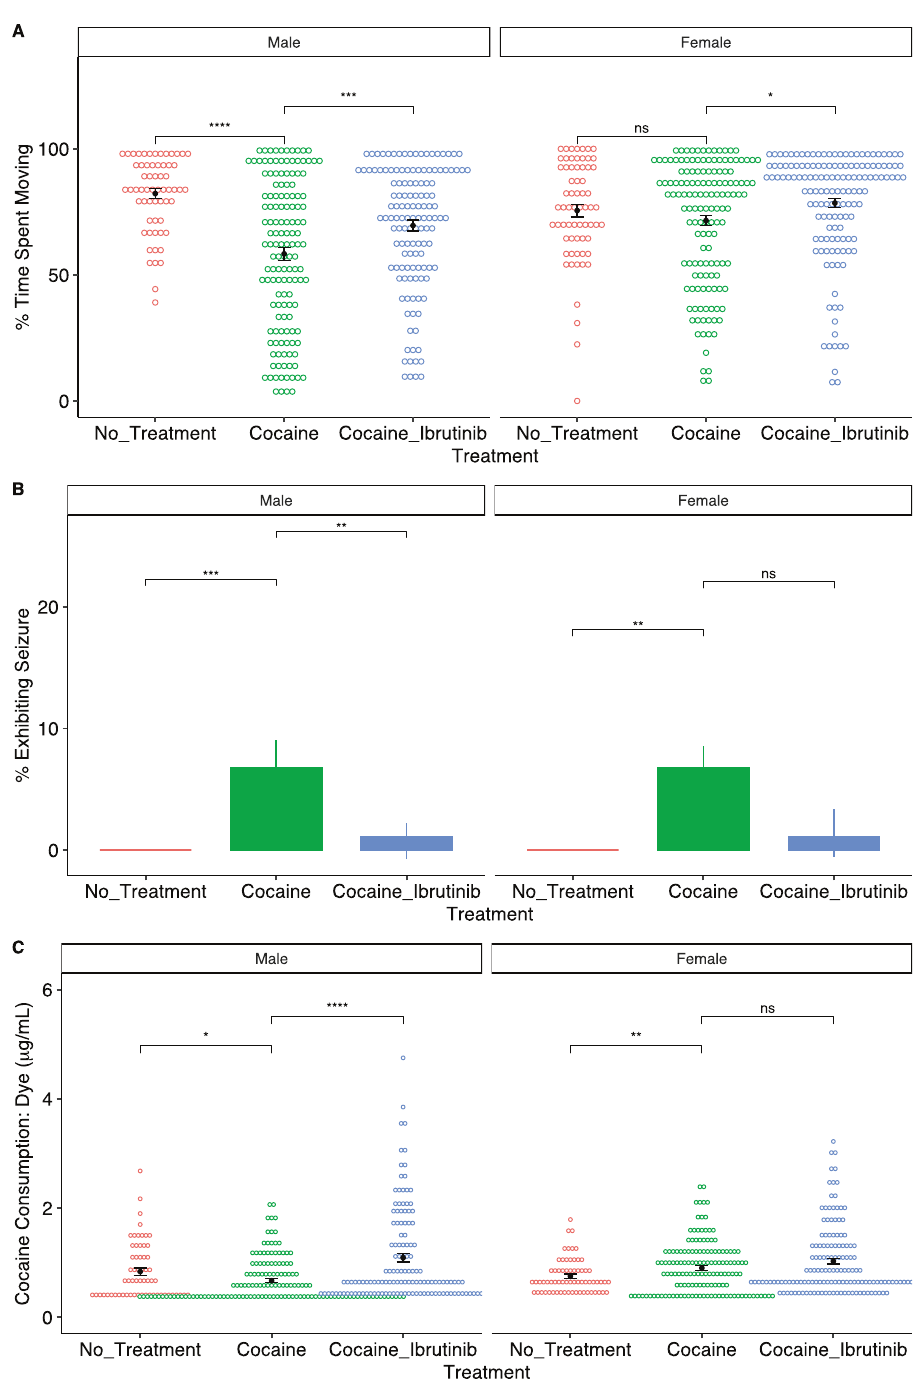
Fig. 5 Ibrutinib in fl uences cocaine-induced startle response, cocaine-induced seizures and cocaine consumption in Drosophila melanogaster . Sample sizes were as follows: n = 61 ( ♂ control), 140 ( ♂ cocaine), 132 ( ♂ cocaine + ibrutinib), 66 ( ♀ control), 141 ( ♀ cocaine), 142 ( ♀ cocaine + ibrutinib). A Dotplot showing the cocaine startle response by condition. B Barplot showing the average seizure activity during the startle response across conditions with 95% con fi dence intervals. C Dotplot showing cocaine consumption across conditions. Colored dots represent individual fl ies and the black dot displays the average for each group and the standard error.ns p > 0.05. * p < 0.05. ** p < 0.01. *** p < 0.001. **** p <